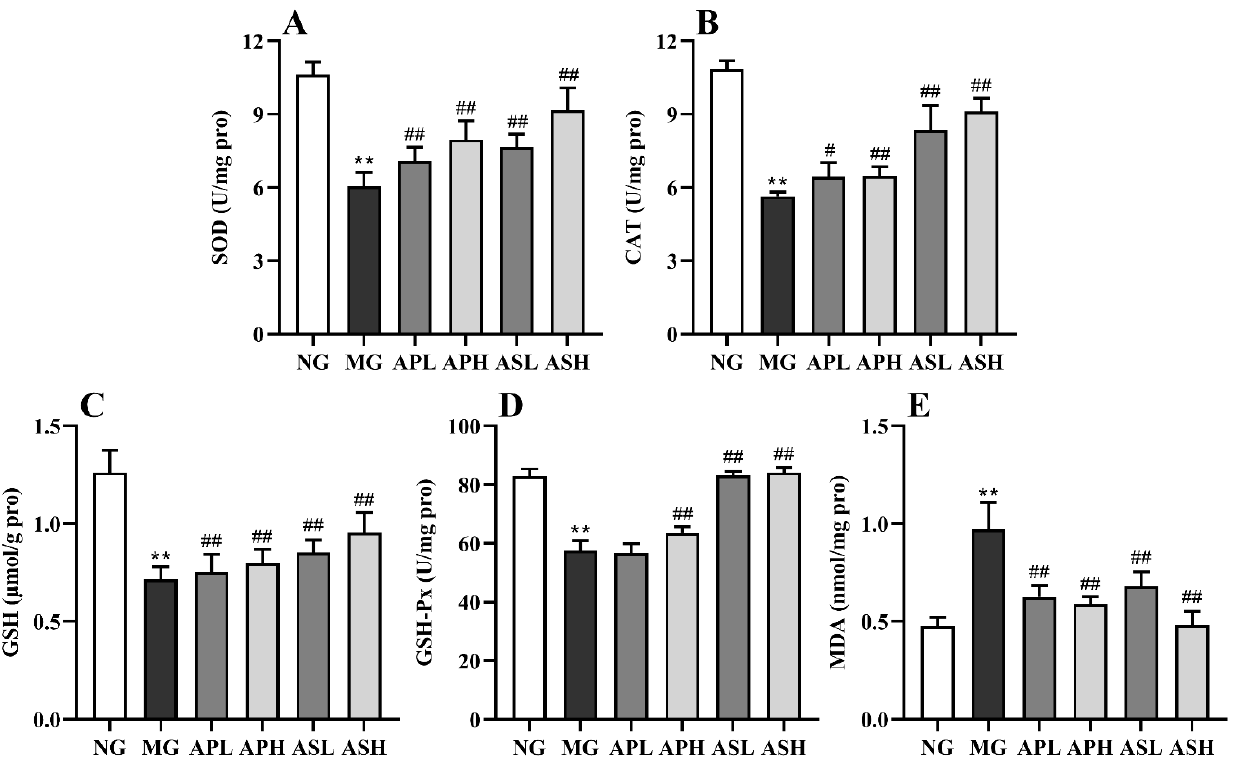
Figure 4. Effect of AP and AS on the antioxidant capacities in ALD mice. ( A ) SOD activity; ( B ) CAT activity; ( C ) GSH activity; ( D ) GSH-Px activity; ( E ) MDA level. Data are expressed as mean ± SD ( n = 12). ** p < 0.01, vs. NG; # p < 0.05, ## p < 0.01, vs. MG.